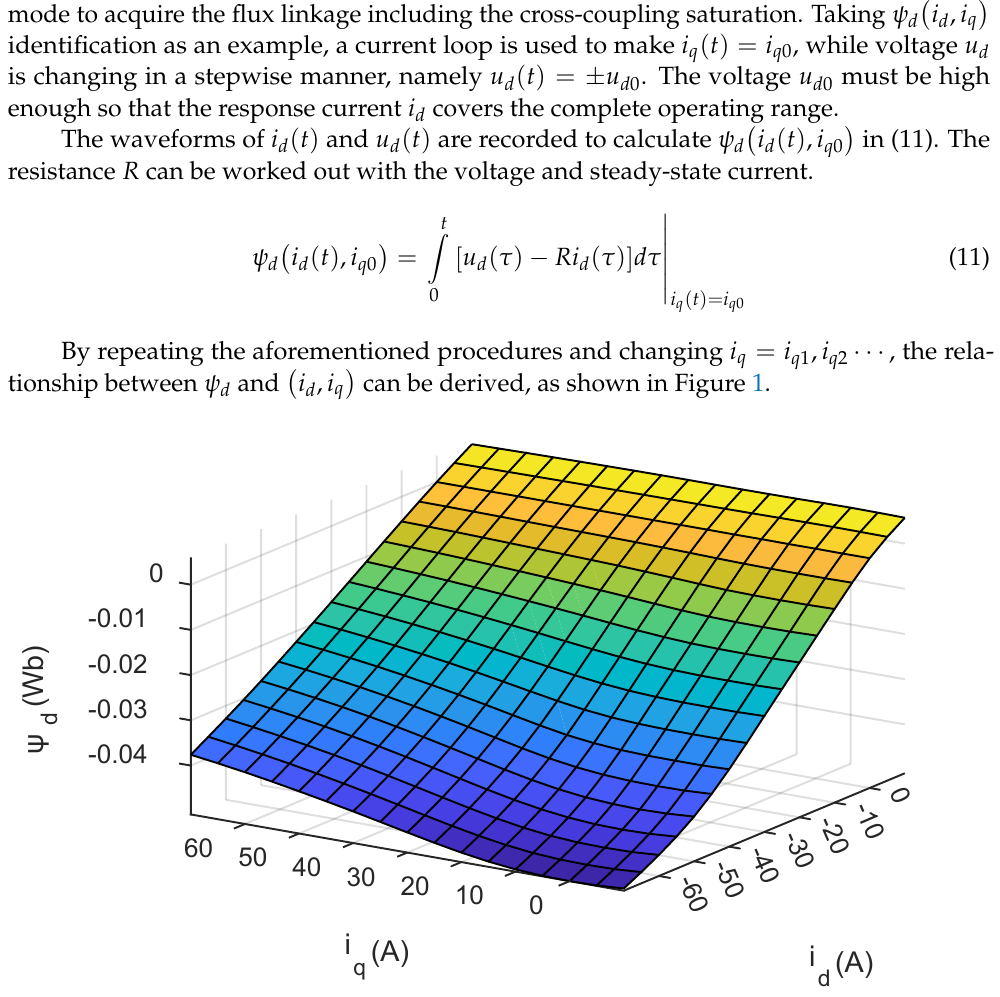
Figure 1. Measurement result of direct-axis flux linkage due to current excitation.